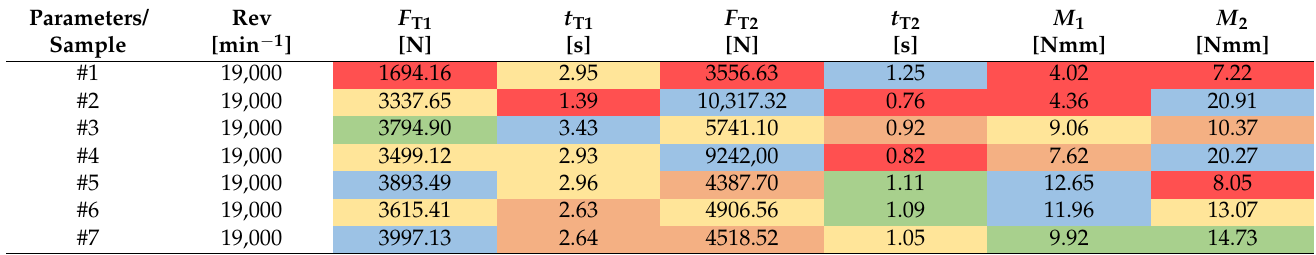
Table 5. Values of force ( F ), torque ( M ) and processing time ( t ) for both phases of friction riveting. Parameters/